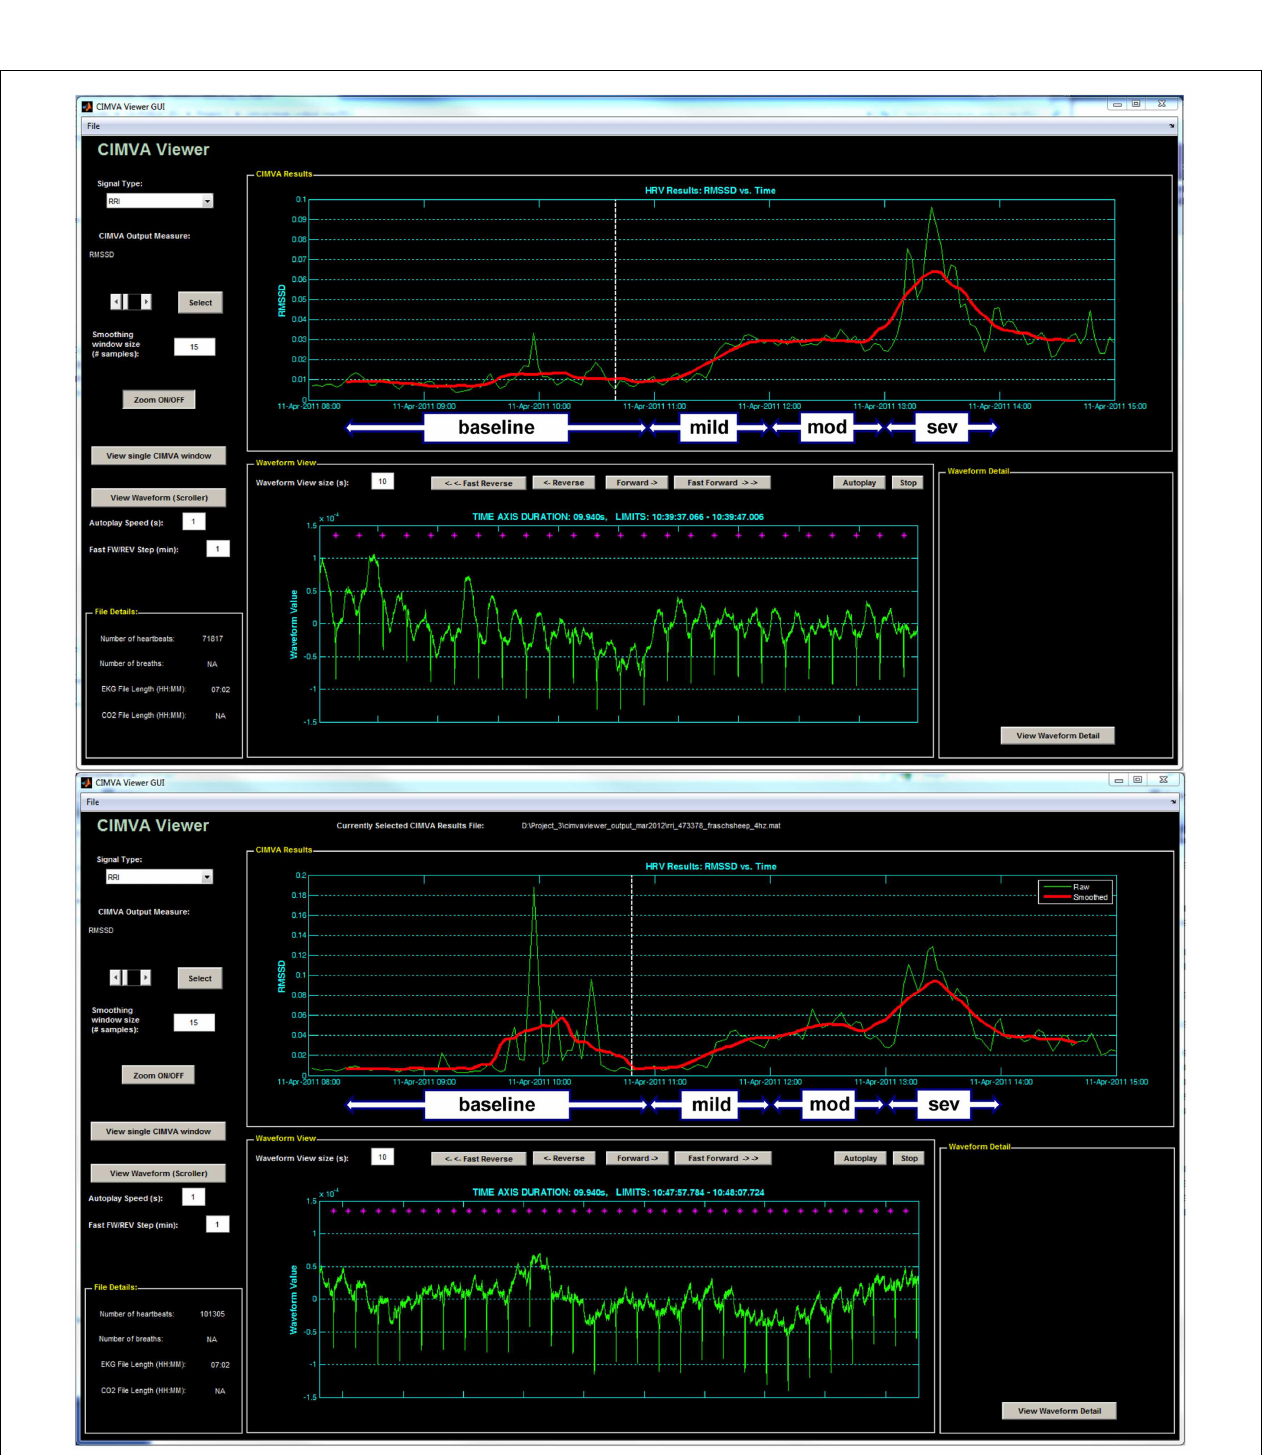
FIGURE 1 |A representative example of the CIMVA fHRV analysis of RMSSD at (top) 1000Hz and (bottom) 4Hz . Note the gradual rise of RMSSD with worsening acidemia (pH decreasing) and an overestimation of RMSSD at baseline in 4Hz sampled fHRV. Mild, mod and sev = mild, moderate, and severe UCO series,